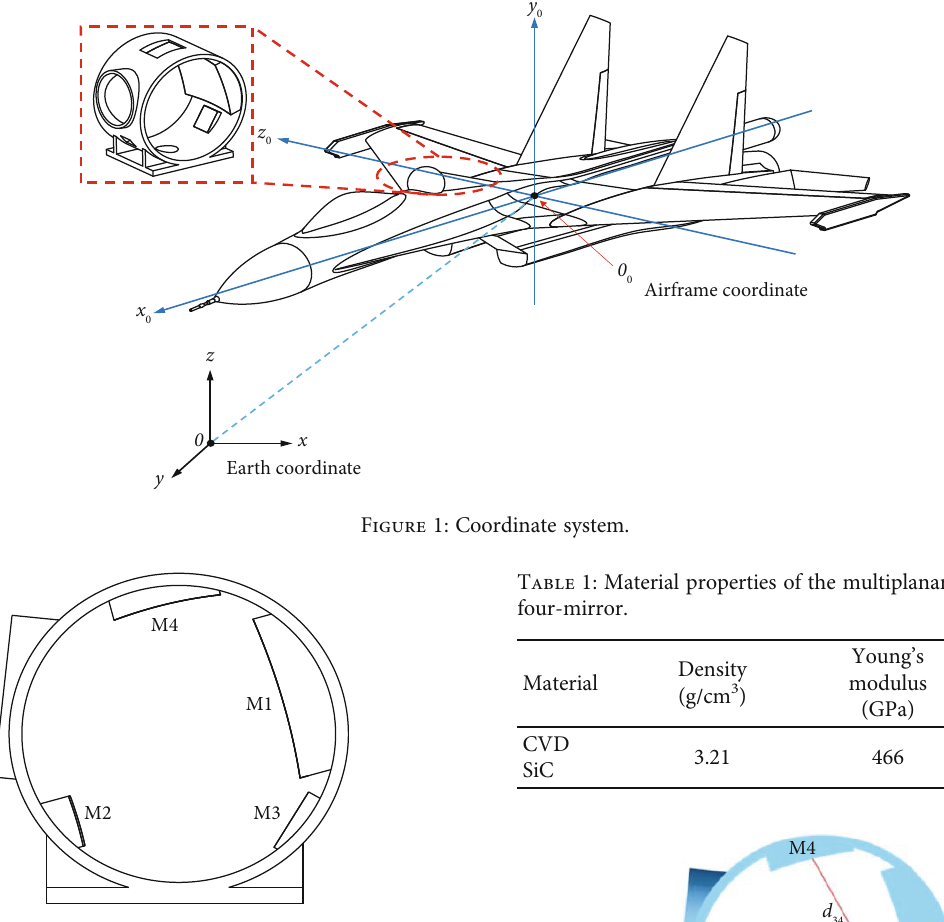
Figure 2: Planar structural graph.